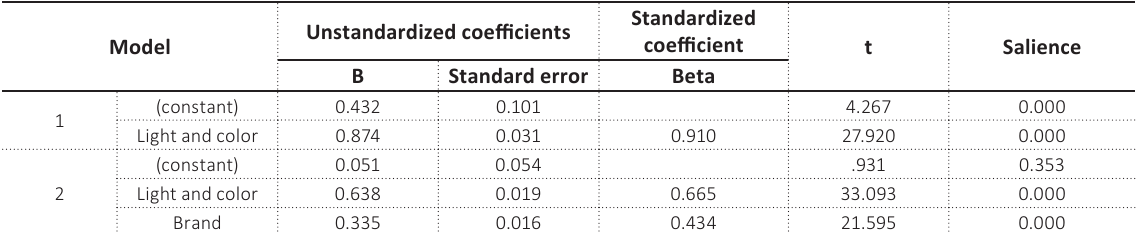
Table 8. Linear regression coefficients of the relationship between light and color, brand image, and consumers’ purchase intention